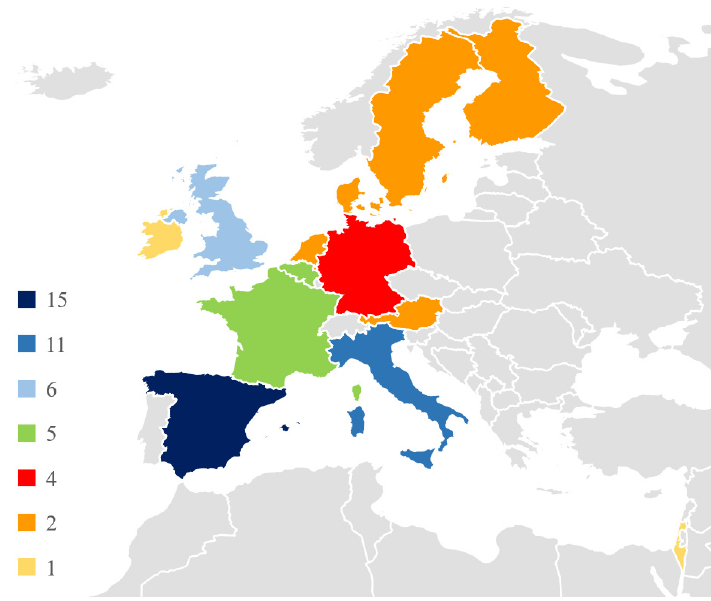
Figure 2. Number of projects per coordinator country.